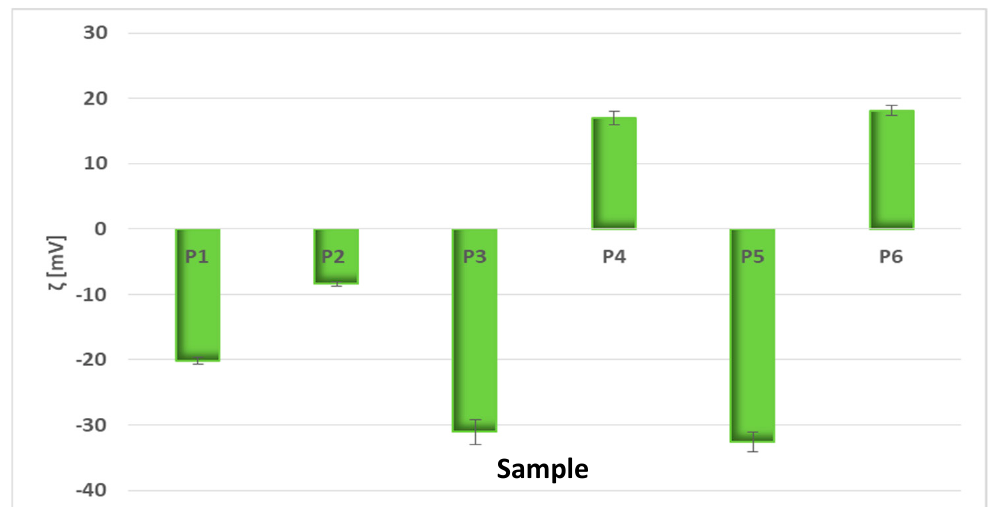
Figure 2. Evaluation of the physical stability of the obtained bio-based materials. Chlorophyll-labeled artificial cell membranes exhibited moderate stability ( ξ P1 = − 20.17 ± 0.49 mV), and after chitosan addition, the zeta potential value increased to − 8.45 ± 0.27 mV (for P2) due to the positive charge of amino functional groups in chitosan. “Green” synthesized silver nanoparticles alone and embedded in biomimetic membranes registered more accentuated electronegative values ( ξ P3 = − 31.1 ± 1.9 mV and ξ P5 = − 32.57 ± 1.5 mV, respectively), thus good stability. In the presence of chitosan, these values shifted to positive values: ξ P4 = +17.5 ± 1.07 mV and ξ P6 = +18.1 ± 0.79 mV, their stabilization with the positively charged chitosan